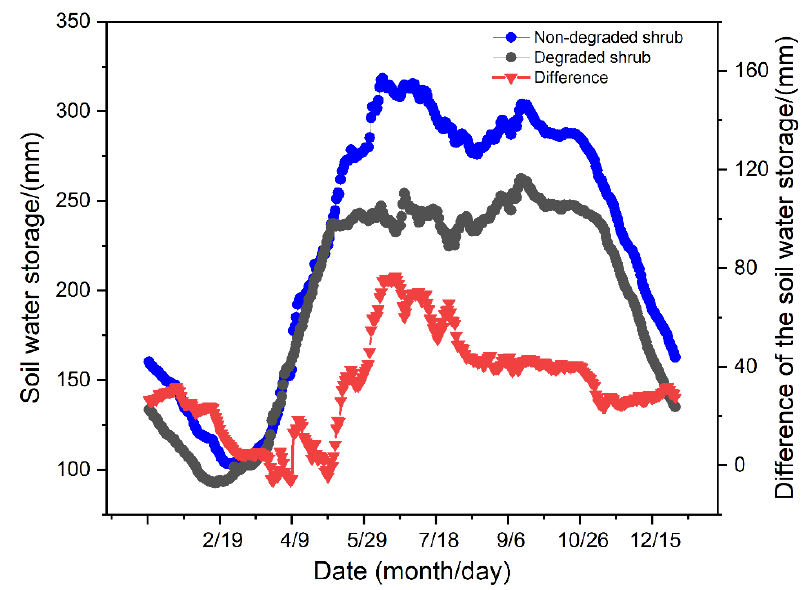
Figure 4. Variation of soil water storage of degraded and non-degraded shrub during the year.